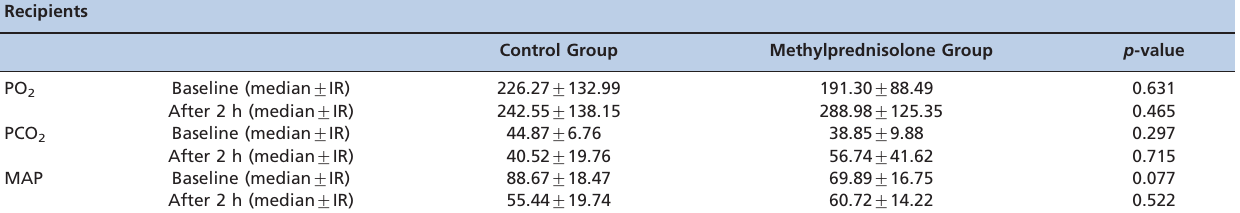
Table 2 - The levels of arterial blood gases and the mean arterial pressure in recipients at baseline and 2 h following lung transplantation.